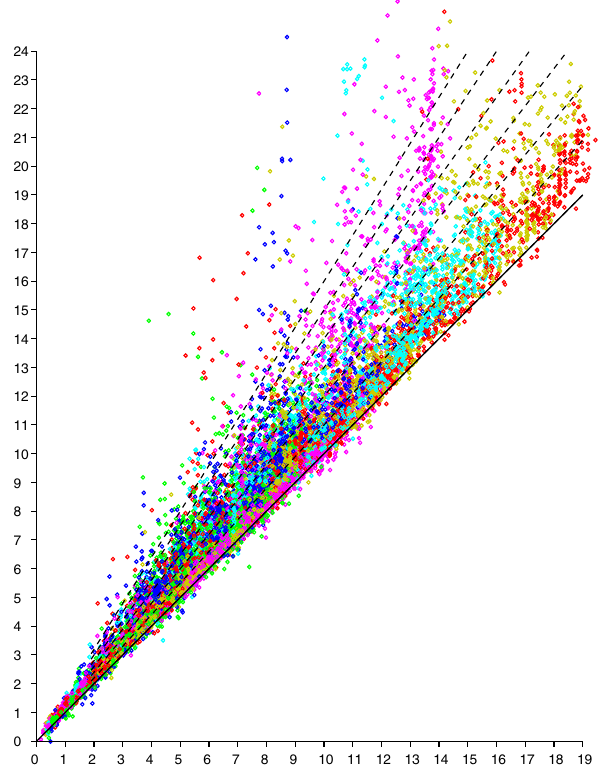
Figure 2. Scattergram of reported distance (vertical axis—meters) versus actual distance (horizontal axis—meters). Results from six responders color coded. (Dashed lines have slope 1.0, 1.1, 1.2 . . . 1.6